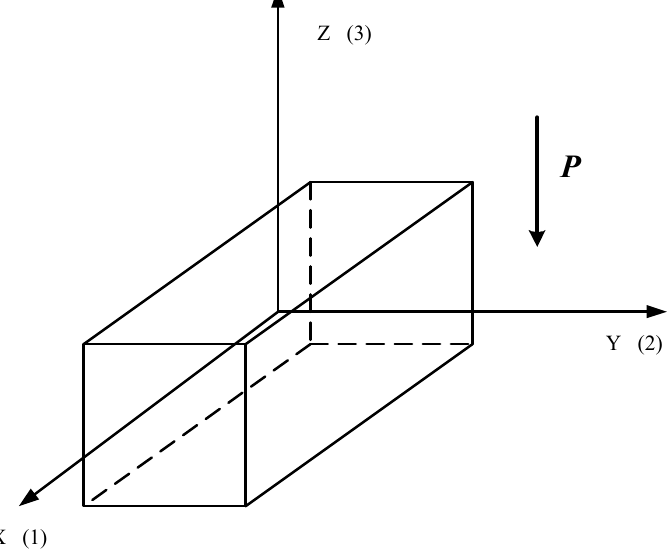
Figure 2. Locations of the axes relative to the polarization vector P .